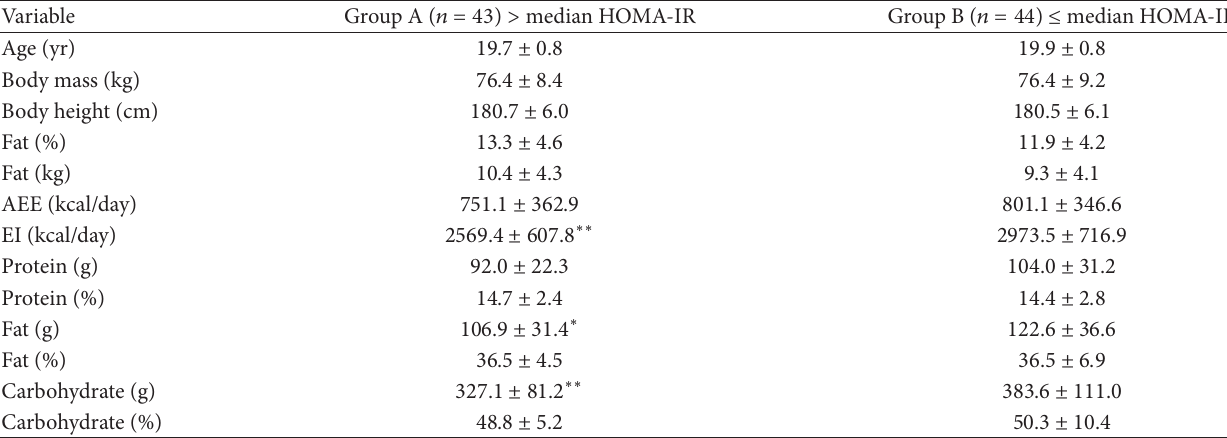
Table 3: Characteristics of the subjects categorized by HOMA-IR median value (means ± SD).